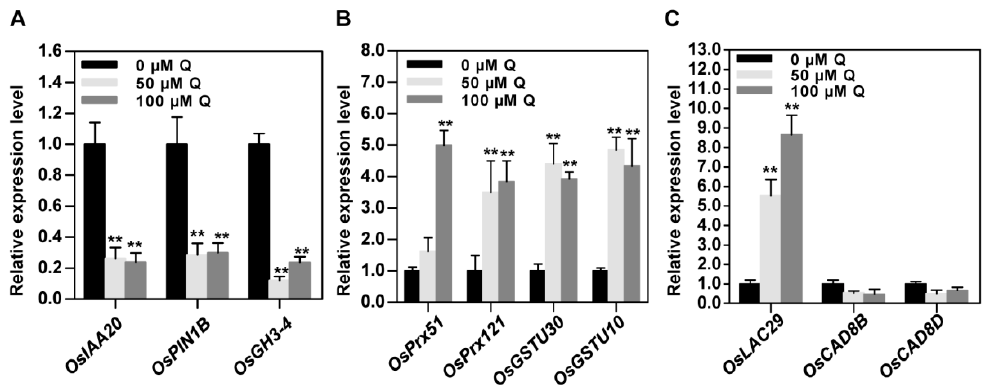
Figure 6. qRT-PCR-based identification of auxin, antioxidant, and cell wall-related DEGs from RNA-seq. ( A ) Validation of several genes involved in the auxin signaling with 0, 50, or 100 µ M of quercetin (Q). ( B ) Validation of several genes involved in the antioxidant activity with 0, 50, or 100 µ M of quercetin (Q). ( C ) Validation of several genes involved in cell wall dynamics with 0, 50, or 100 µ M of of quercetin (Q). Values are means ± SD ( n = 4). The asterisks indicate a significant difference relative to the untreated plants (Student’s t test, ** p <